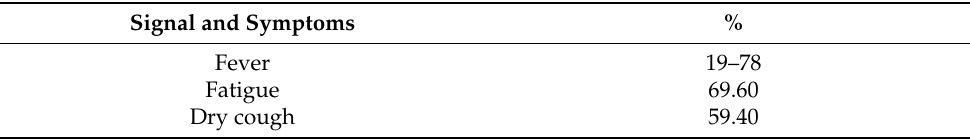
Table 1. Basic characteristics of COVID-19